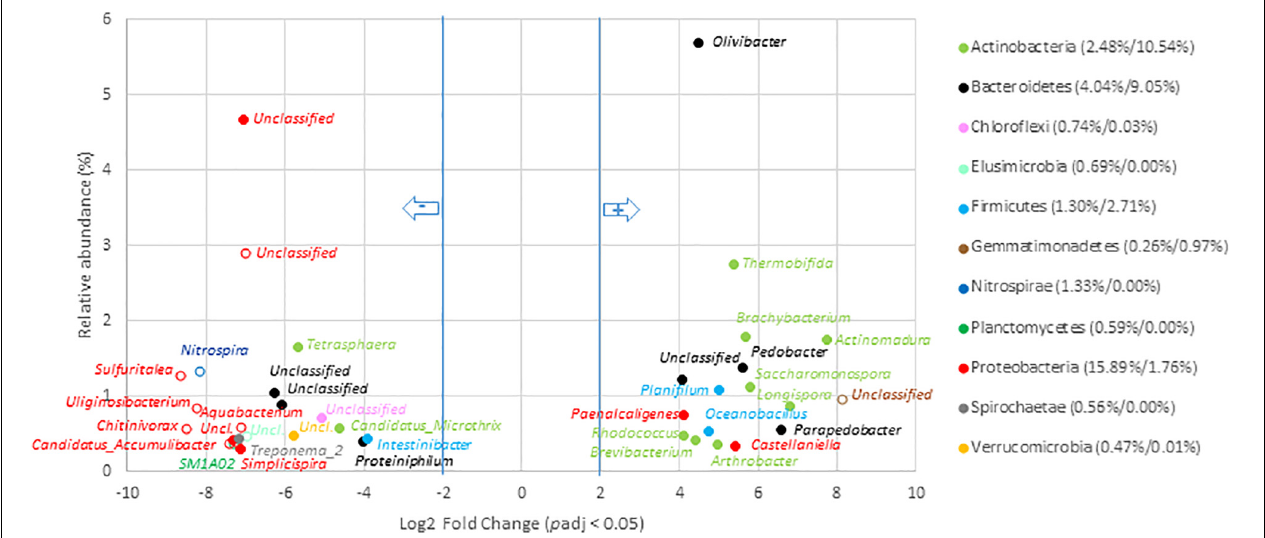
FIGURE 6 | Genera with significant change in relative abundance after composting of organic waste samples. Genera with significant ( p adj < 0.05) decrease in compost compared to OW samples (left part of the plot) are presented according to their initial relative abundance in OW, while genera with a significant increase in compost compared to OW samples (right part of the plot) are presented according to their relative abundance in compost. Genera are colored according to the phylum to which they belong. Full mark represents genus present in the core microbiome; empty mark represents genus not present in the core microbiome (OW and compost core microbiomes were, respectively, considered at the left and right part of the plot). Numbers in brackets represent the sum at the phylum level of relative abundance of all genera with significant change after composting calculated before and after composting (OW%/Compost%). Only genera with relative abundance ≥ 0.3% and significant change (-2 ≥ Log2 FC ≥ +2, p adj < 0.05, minimum normalized read count = 10) are shown (see Supplementary Table 12 for the other